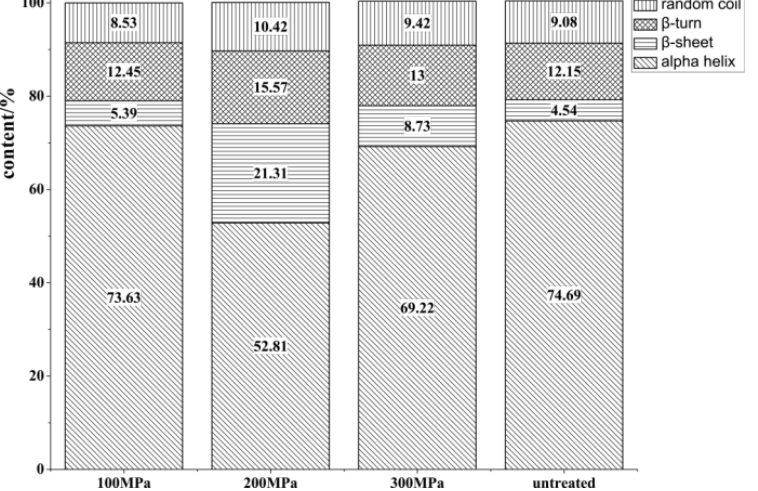
Figure 4. Changes of protein secondary structure of adductor muscle at scallop interface under ultra-high pressure.